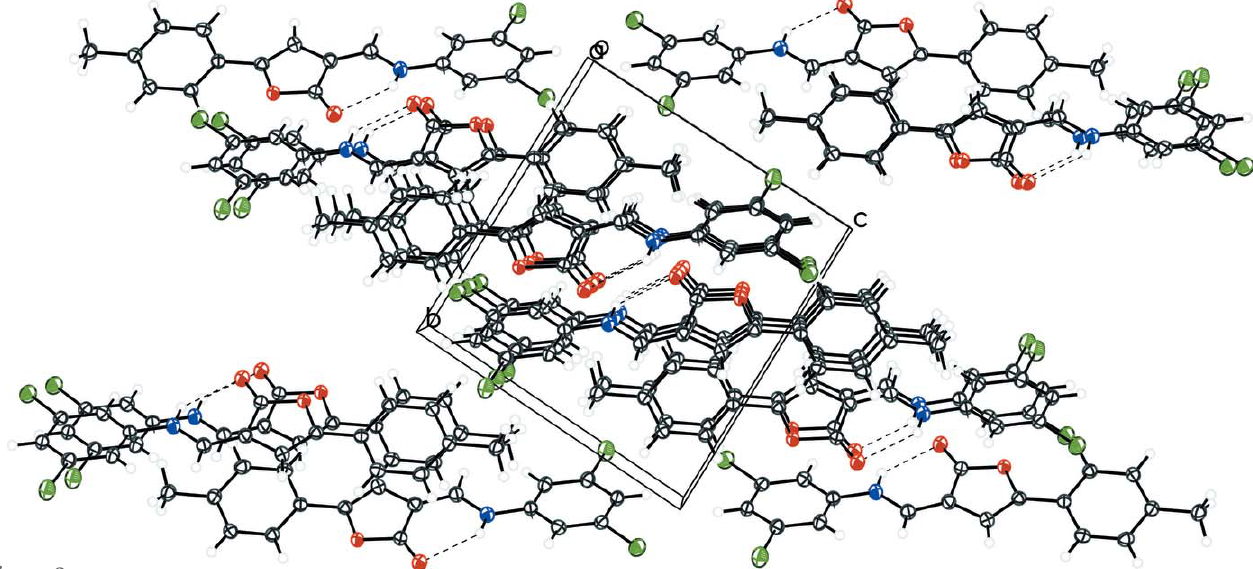
Figure 2 The crystal packing of the title compound, viewed down the a axis.